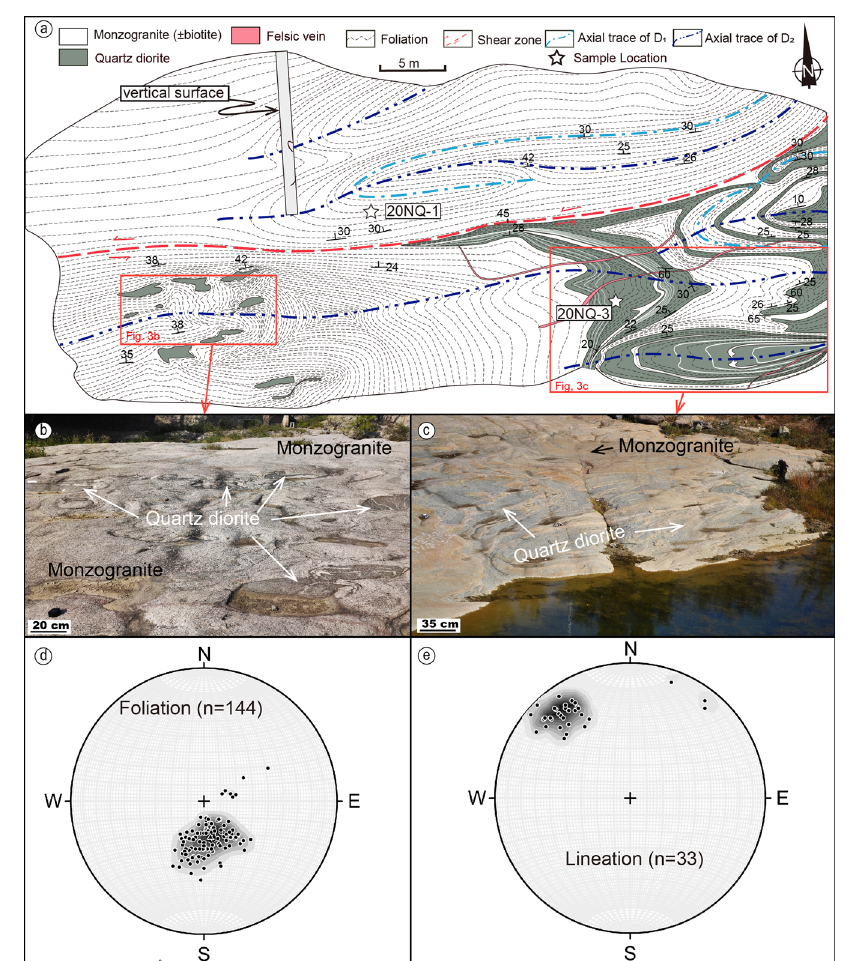
Fig.3|DetailedstructuralmapoftheXiashiliuRiverexposureofthebasement complex of the pro fi le. The location of this out crop is shown in Fig. 1d. a Struc- tural mapof an exposureofthe multi-component basement complex, where three episodesofdeformationarerecognizedwithdifferenttracesoffoldaxes.Mapping was performed at 1:50 scale, using a grid-line technique and vertical drone-hosted